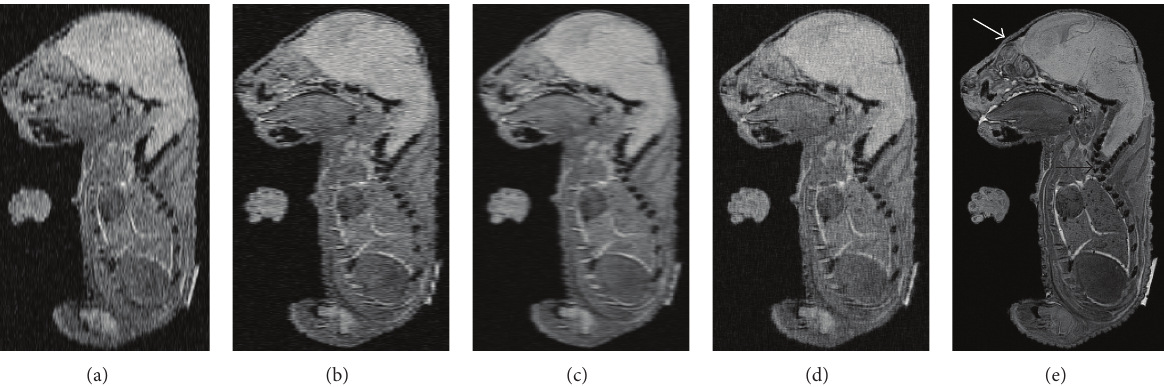
Figure 7: 2D sagittal view of SRR images of the ex vivo embryo based on different acquisition geometries: (a) interpolated, (b) shifted, (c) rotational, (d) orthogonal, and (e) isotropic. White arrow indicates structures in the nasal cavity not clearly observed in the corresponding SRR images.